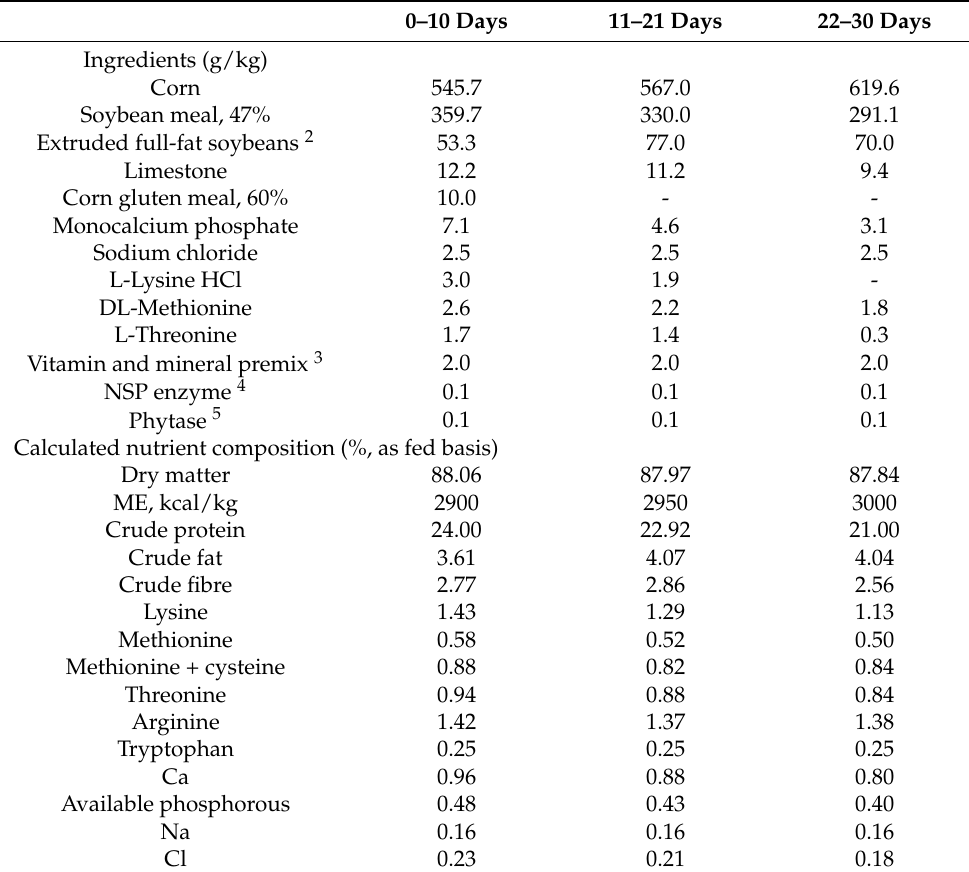
Table 1. Ingredients and nutrient composition of the experimental diets 1